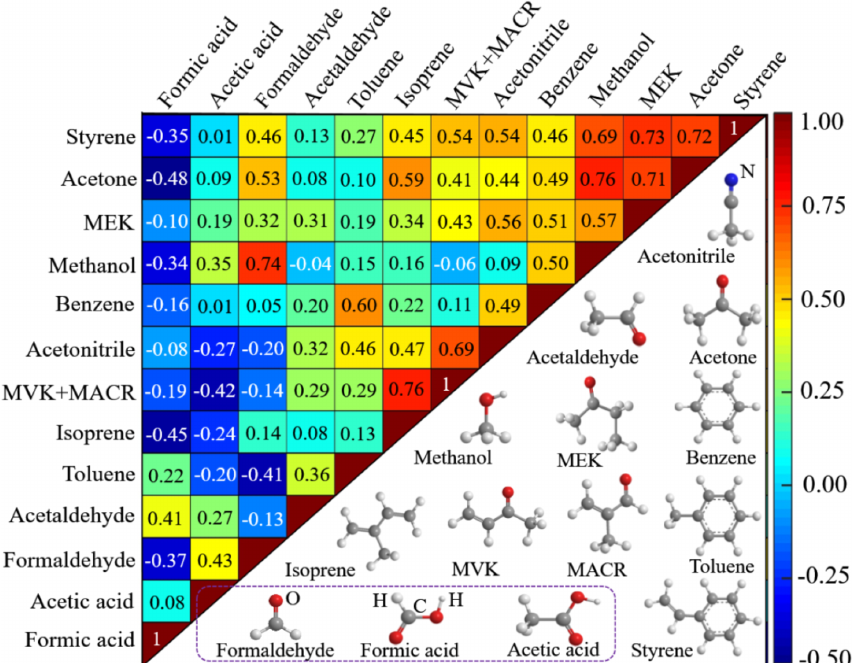
Figure 9. Correlation of the exchange of measured VOC species (upper left) and their molecular structures (lower right). Correlation between each pair of VOCs is reflected by the correlation coefficient, shown in the plot. The correlation coefficient between each individual species itself is 1, a correlation coefficient of 0 means no correlation, and − 1 implies complete